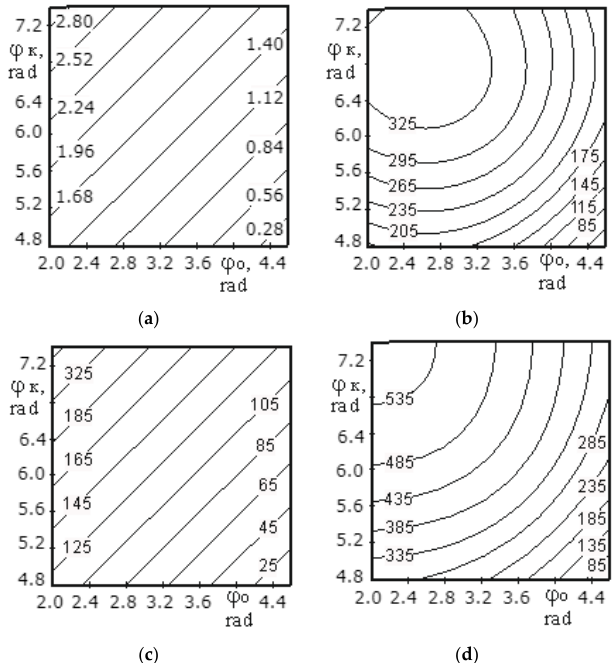
Figure 14. Dependences of the power value on the degree of mixer loading for the middle screw: ( а ) the surface constructed based on calculations on the first component; ( b ) the surface constructed based on calculations on the second component; ( c ) the surface constructed based on calculations on the third component; ( d ) the surface representing the change in the total power value for all three components.